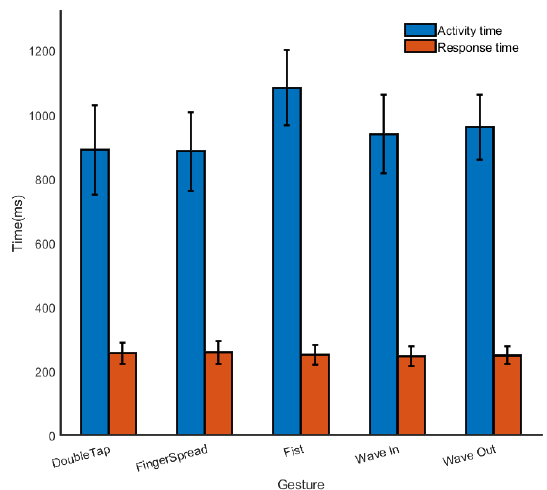
Figure 7. Average response time for each gesture.